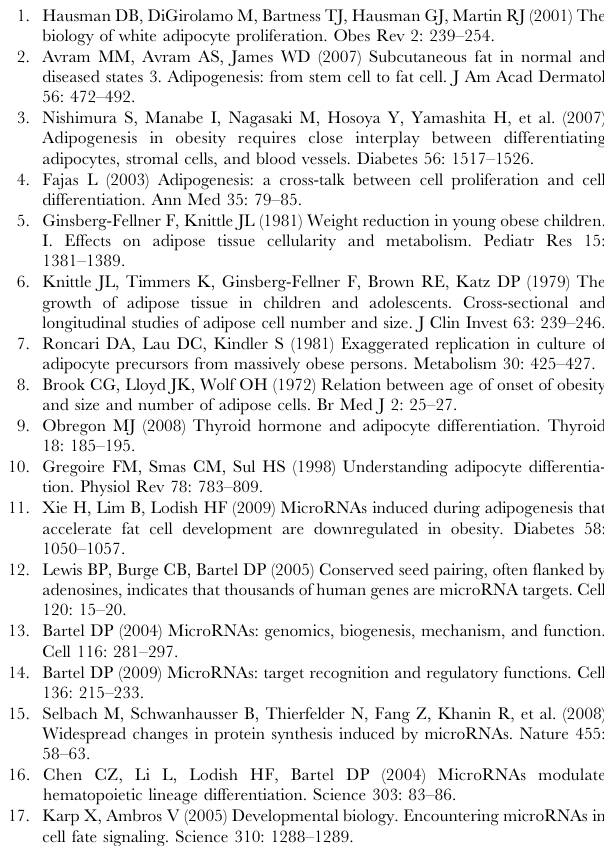
Figure S1 Validation of microarray results. For 6 of the most regulated miRNAs in both in vitro (pre-adipocytes ( . ), adipocytes ( ¤ ) at 7th day and mature adipocytes ( m ) at 14th day) and in vivo (subcutaneous fat biopsies from non-obese ( # ), obese non-DM-2 ( ¤ ) and obese and DM-2 ( % ) subjects) analyses, microarray results were validated by RT-PCR assays. RT-PCR expression values for all miRNAs are the ratio relative to previously tested and validated miRNA endogenous control (RNU48). Microarray values are the ratio relative to an internal control. Figure S2 Relationship between miRNAs and lipogenic path- way gene expression. Plots: Comparisons by RT-PCR of key- lipogenic mRNAs levels during adipogenesis. Expressions of all mRNAs are normalized to internal control (Cyclophilin A, PPIA) and plotted as fold-changes relative to this endogenous control at day 0, 7 and 14. Data are expressed as mean 6 SEM (n= 6) for FAS, ACC, FABP4, ADIPOQ, PPARg and RBP4. Table: Significant correlates of miRNA and the selected adipo/lipogen- ic-related gene expression levels. The abbreviations used are: FAS, Fatty Acid Synthase; ACC, Acetyl-CoA Carboxilase; FABP4, Fatty Acid-Binding protein 4; PPARg, Peroxisome proliferator-